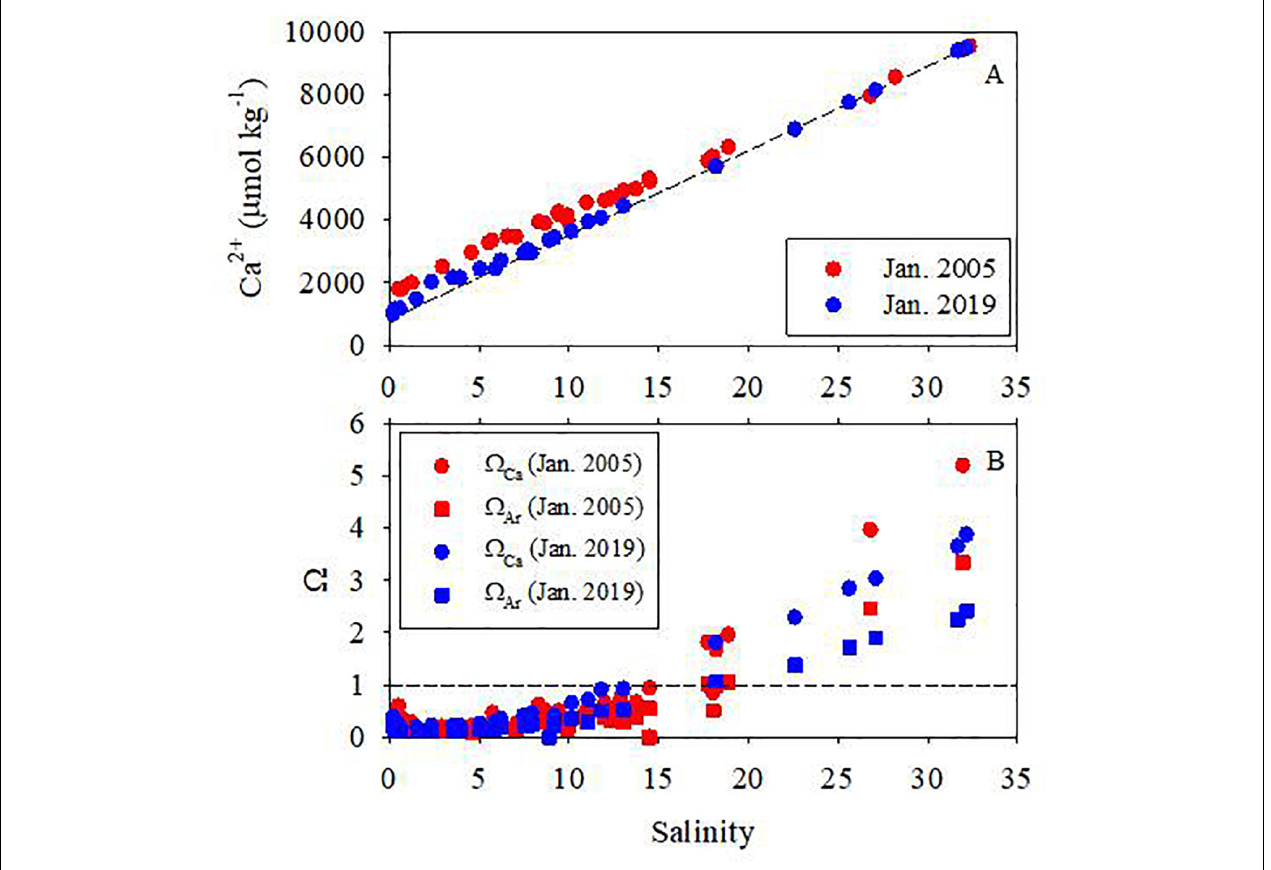
FIGURE 6 | Distributions of Ca 2 + concentration and saturation state indices of calcite ( (cid:127) Ca ) and aragonite ( (cid:127) Ar ) in the surface water of the Pearl River estuary. The dashed line in panel (A) is the conservative mixing line. The dashed line in panel (B) represents (cid:127) = 1. Legends are the same for both